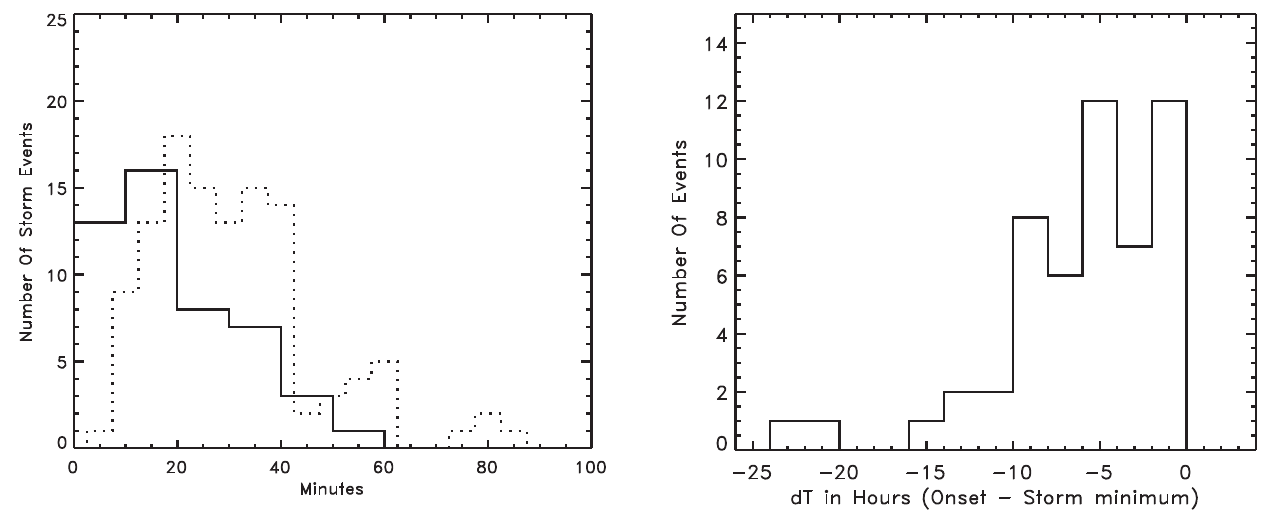
Fig. 6. Histogram of the length of expansion phases for auroral events during the development of the magnetic storm main phase (solid lines). Superimposed as dotted lines is a histogram for ex- pansion phases for isolated substorms (from Gjerloev et al., 2007).